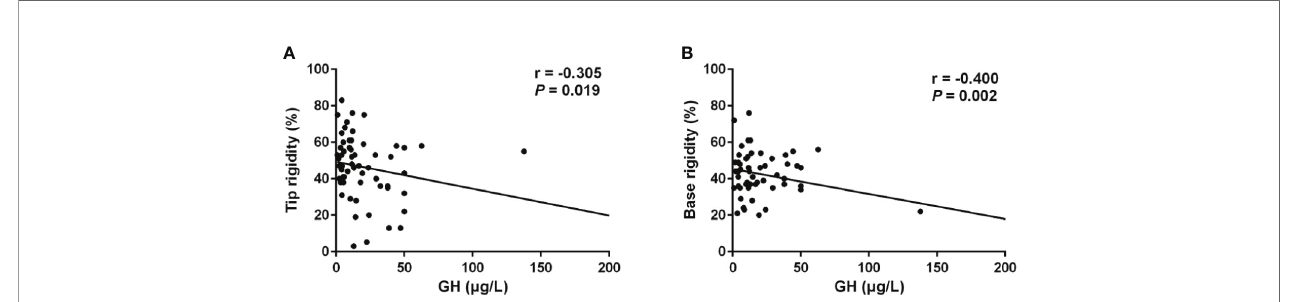
FIGURE 1 | Random GH levels were negatively correlated with the Rigiscan parameters. (A) Random GH levels were negatively correlated with average tip rigidity ( r = -0.305, p = 0.019). (B) Random GH levels were negatively correlated with the average base rigidity ( r = -0.400, p =